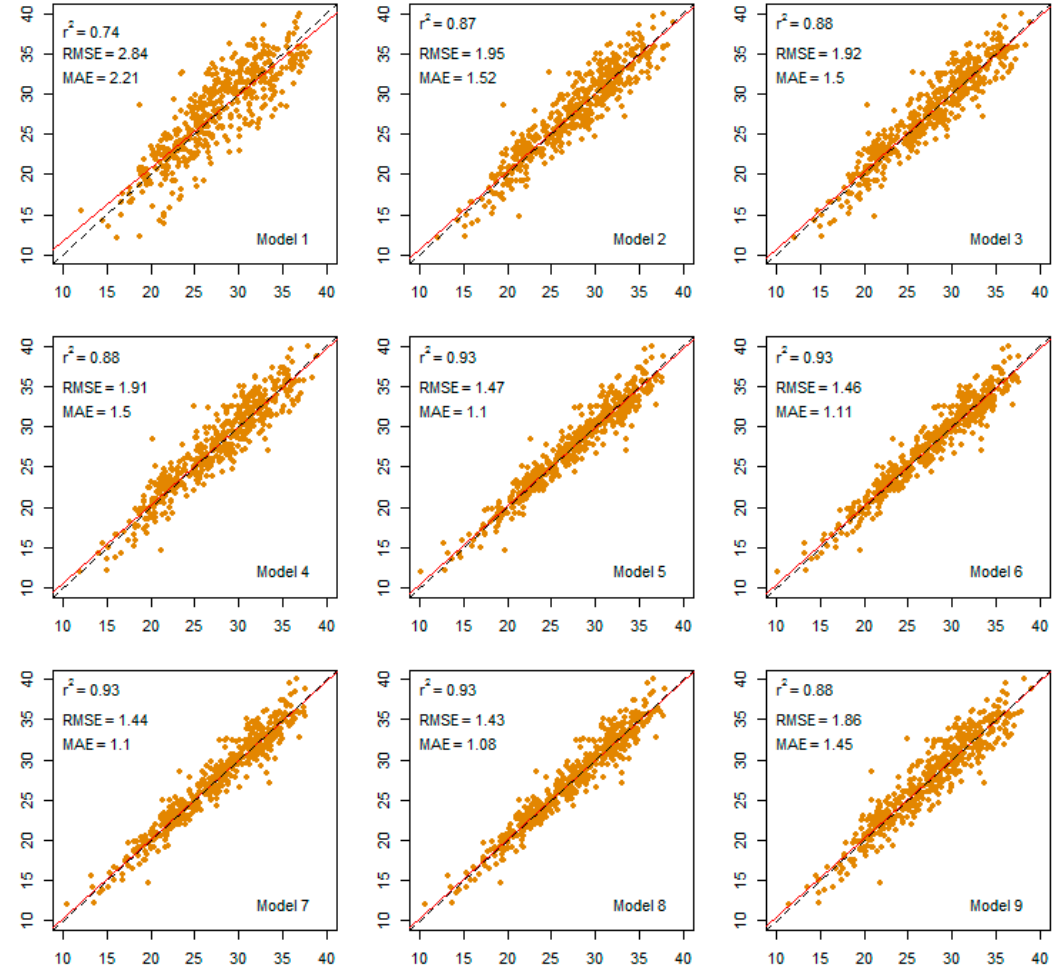
Figure 4. The relationship between T a observed (y-axis) and T a estimated (x-axis) using Models 1–9. The dashed black line indicates the 1:1 line. The solid red line shows the regression line.